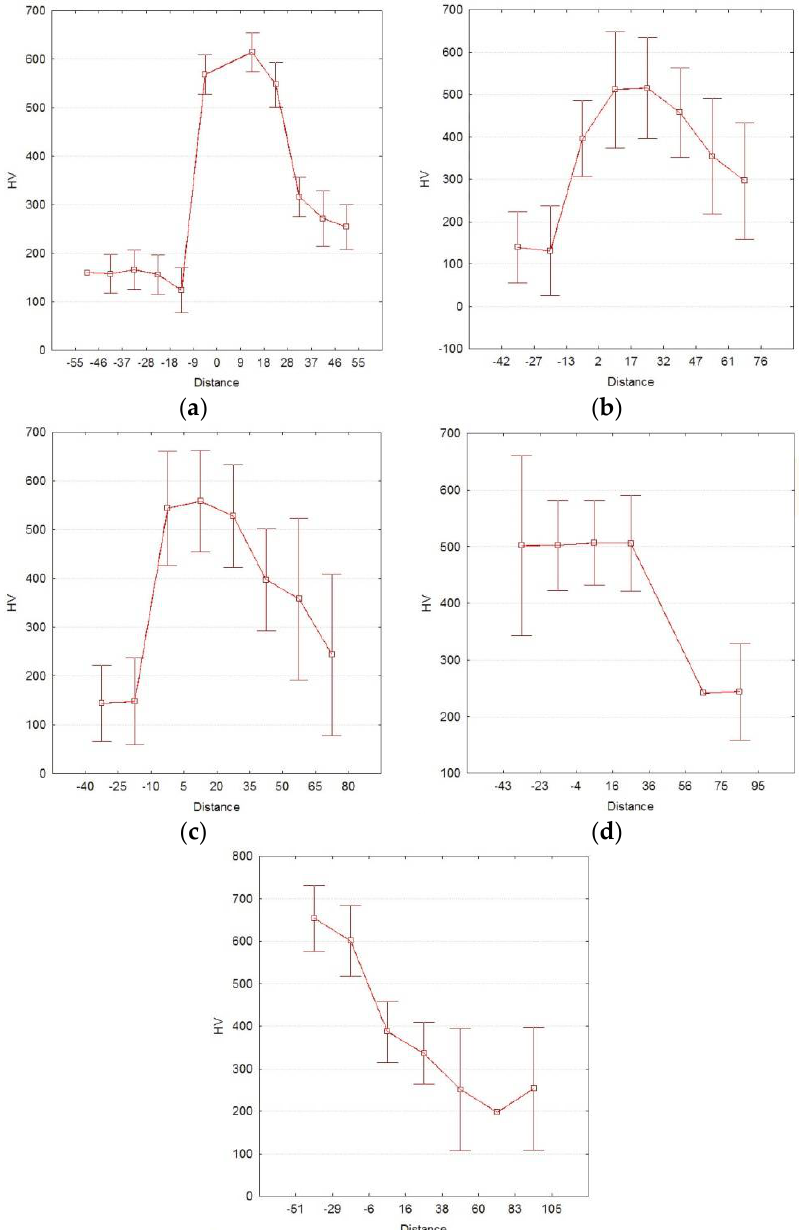
Figure 6. Distribution of hardness at the bimetal interface zone: ( a ) SLM scanning mode 1; ( b ) SLM scanning mode 2; ( c ) SLM scanning mode 3; ( d ) SLM scanning mode 4; ( e ) SLM scanning mode